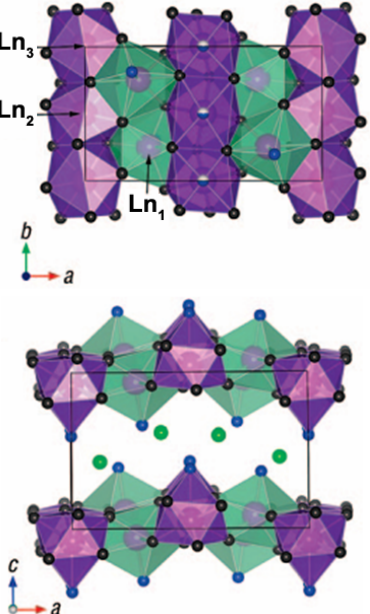
Fig. 1 A schematic illustration of the crystal structure of Ln 2 (OH) 5 Cl· n H 2 O. Reproduced with permission from Ref. [6], © American Chemical Society